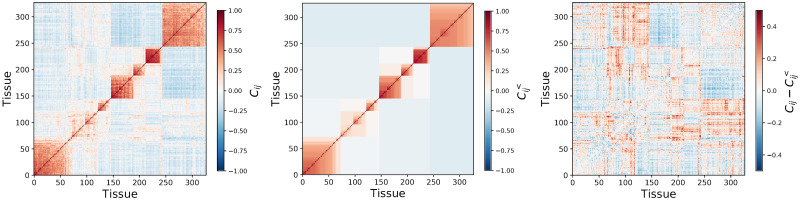
Correlation matrix from tissue-gene micro-array data of patients affected by lung cancer.The upper left plot is the sample correlation matrix, the upper right plot is the result of hierarchical and average-linkage averaging (HCAL). The bottom left plot is the difference between the two: it still has evident structure unaccounted for by HCAL.